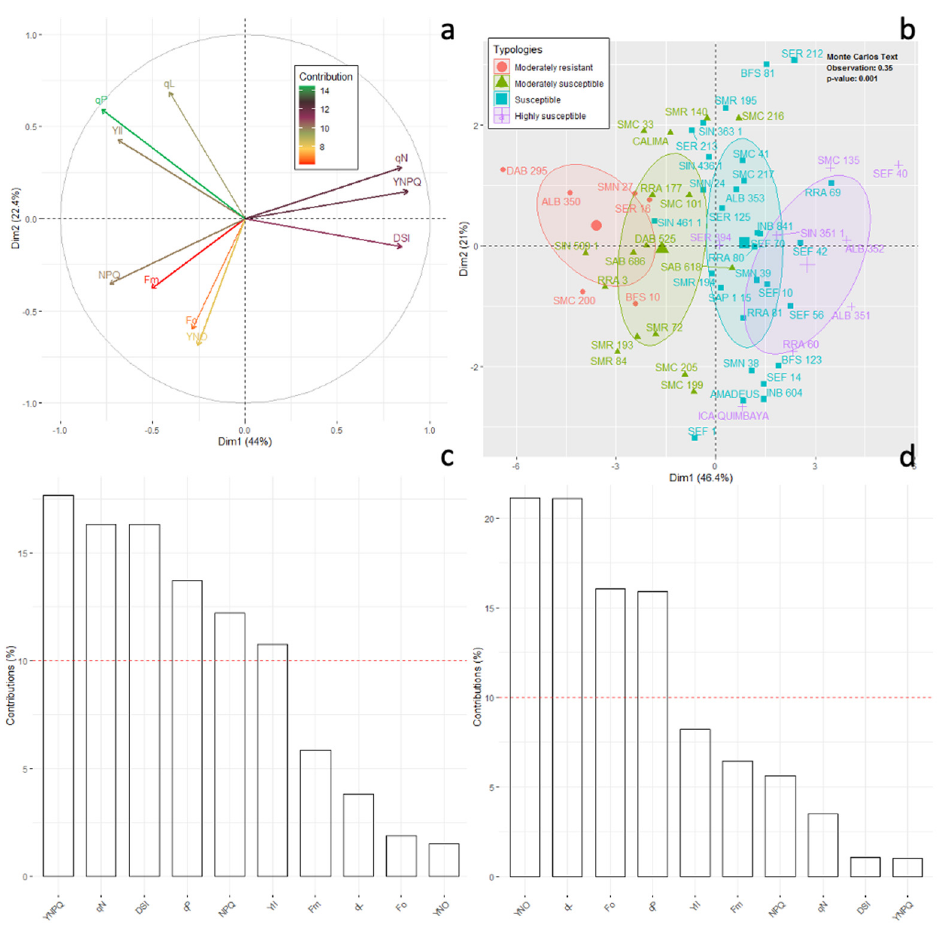
Figure 5. Projection of chlorophyll fluorescence variables grouped by the different types of common bean genotypes on the F1/F2 factorial plane of the principal component analysis (PCA). ( a ) Cor- relation circle for chlorophyll fluorescence variables. The variables with the highest to the lowest contribution are denoted with a color gradient from green to red. ( b ) Classification of common bean genotypes from chlorophyll fluorescence variables and disease susceptibility index (DSI). ( c , d ) Con- tribution of chlorophyll fluorescence variables to the formation of the F1/F2 principal components of the PCA under different types of common bean genotypes. Variables above the red line presented higher contributions in each component ( p < 0.05). Acronyms are shown in Table 1.